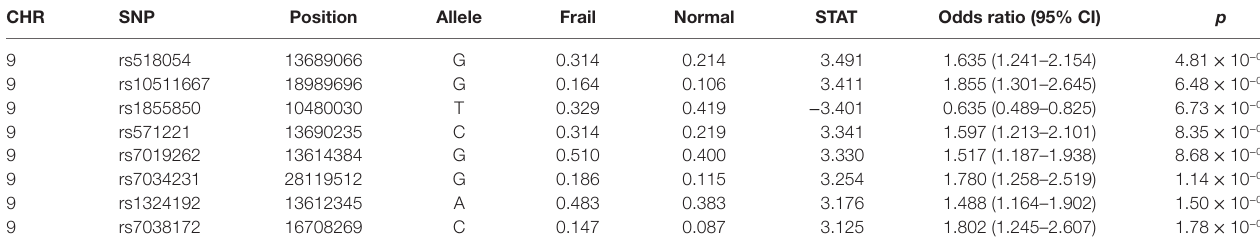
Table 2 | Logistic regression analysis of 9p21-23 locus with Frailty with genotyped SNPs adjusted for age and gender (Model 1). chr snP Position allele Frail